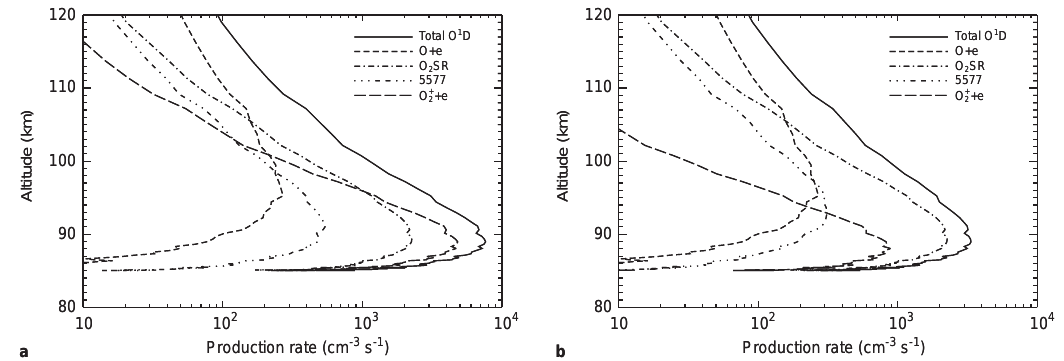
Fig. 2. a O( 1 D) production rates from various sources with normal [NO] and a 50 keV monoenergetic electron spectrum. The O( 1 D) state is completely quenched in the 100 km region. b Same as a but with high